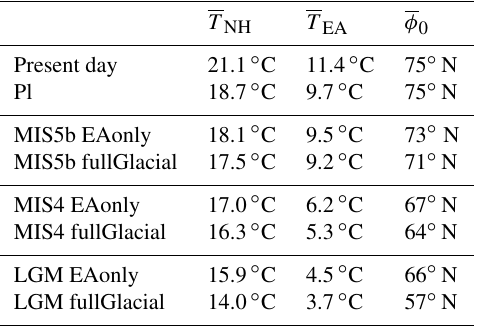
Table 2. Average summer (JJA) temperature in the Northern Hemi- sphere T NH , in Eurasia T EA (average within the area 20 ◦ W, 180 ◦ E, 45 and 90 ◦ N), and the average latitude of the zero-degree isotherm φ 0 in the PI OHT